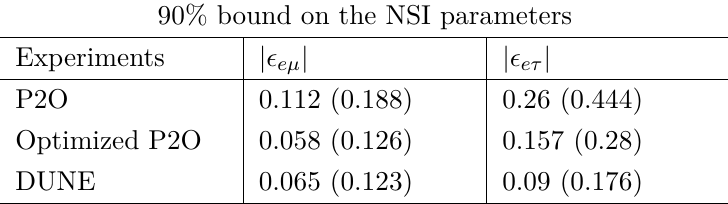
Table 5 . 90% bound on the NSI parameters. The numbers in the parenthesis corresponds to the case when both (cid:15) eµ and (cid:15) eτ are included in the analysis.